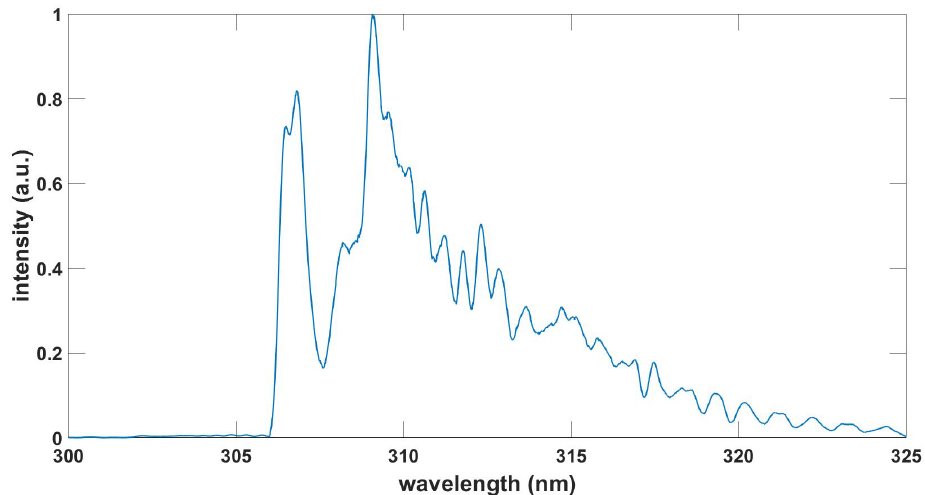
Figure 6. Computed OH spectrum, ∆ v = 0, δ λ = 0.35nm, T = 3.39 kK, see BESP.m script and Ref. [30].